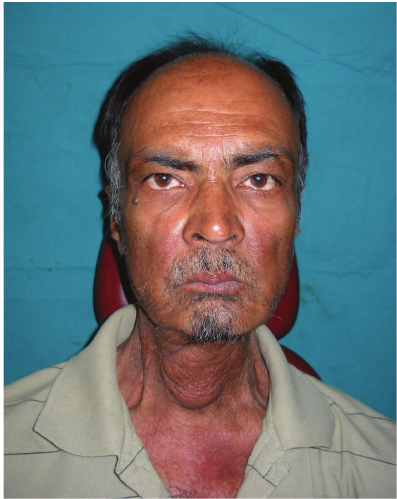
Figure 2: Preoperative extraoral view.